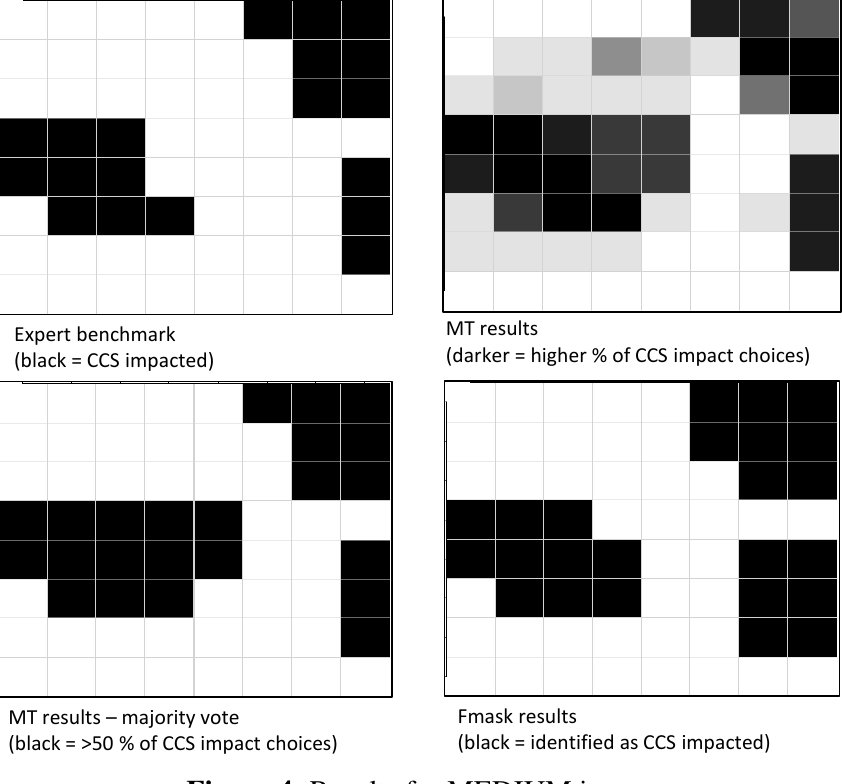
Figure 4. Results for MEDIUM image.